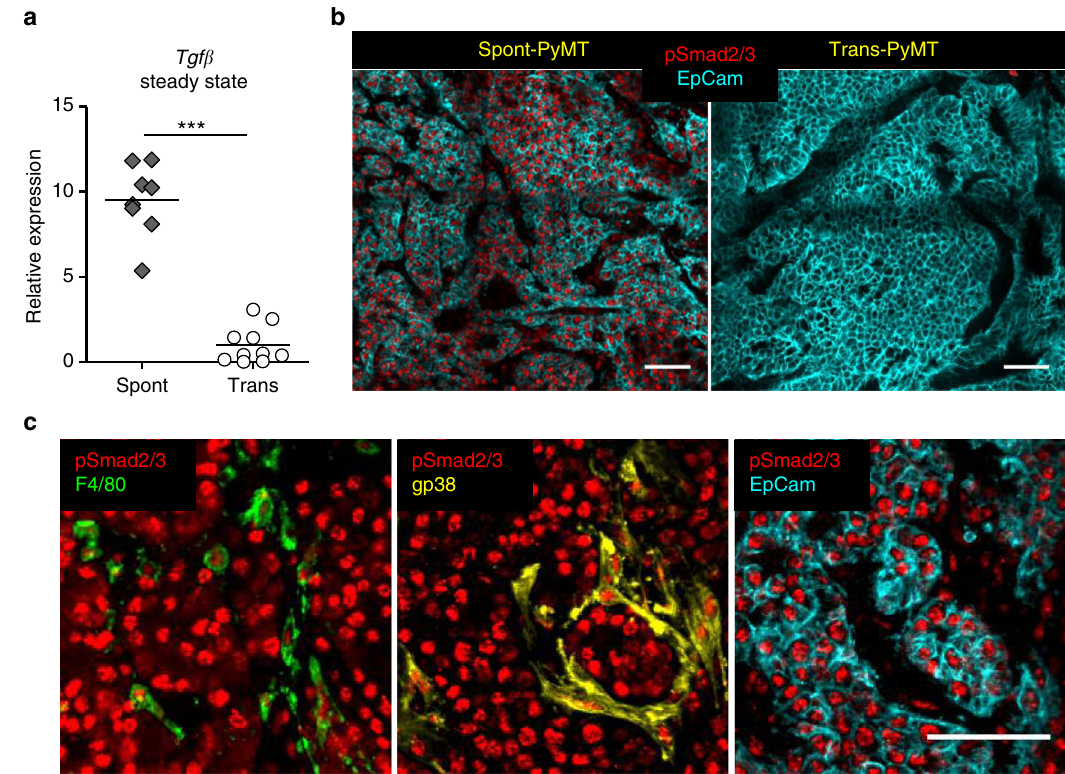
Fig. 5 TGF β expression is associated with pSmad2/3 in Spont-PyMT tumors. a mRNA levels of Tgf β were measured in untreated Spont-PyMT (gray diamonds) and Trans-PyMT (open circles) tumors, right after tumor dissociation. The relative expression, normalized to Trans-PyMT tumors, is shown. Each dot corresponds to one tumor. Cumulative data from Trans-PyMT mice: n = 10 and Spont-PyMT mice: n = 3. Student's t test. * p < 0.05; ** p < 0.01; *** p < 0.001. b Tumors slices from Spont- and Trans-PyMT-untreated mice were stained with anti-EpCAM (blue) and anti-pSmad2/3 (red) Abs. c In Spont-PyMT tumors, pSmad2/3 + cells (red) may be myeloid cells (F4/80 + , green), fi broblasts (gp38 + , yellow), or tumor cells (EpCAM + , blue). Note that the 2nd and 3rd images, not superimposed for clarity, are from the same image fi eld. Images are representative of Spont-PyMT: n = 3 mice; Trans-PyMT: n = 3 mice, from three independent experiments for each group of mice. In b and c , scale bars = 50 µ m. Source data are provided as a Source Data fi